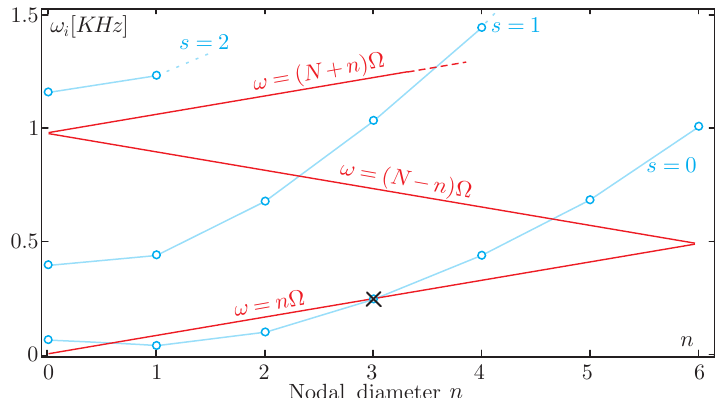
Figure 1. Natural frequencies versus number of nodal diameters and zig-zag-shaped excitation lines for a given rotation speed Ω . In the example, N = 12, and the resonance condition is achieved for n = 3 and s = 0; it is indicated by × .